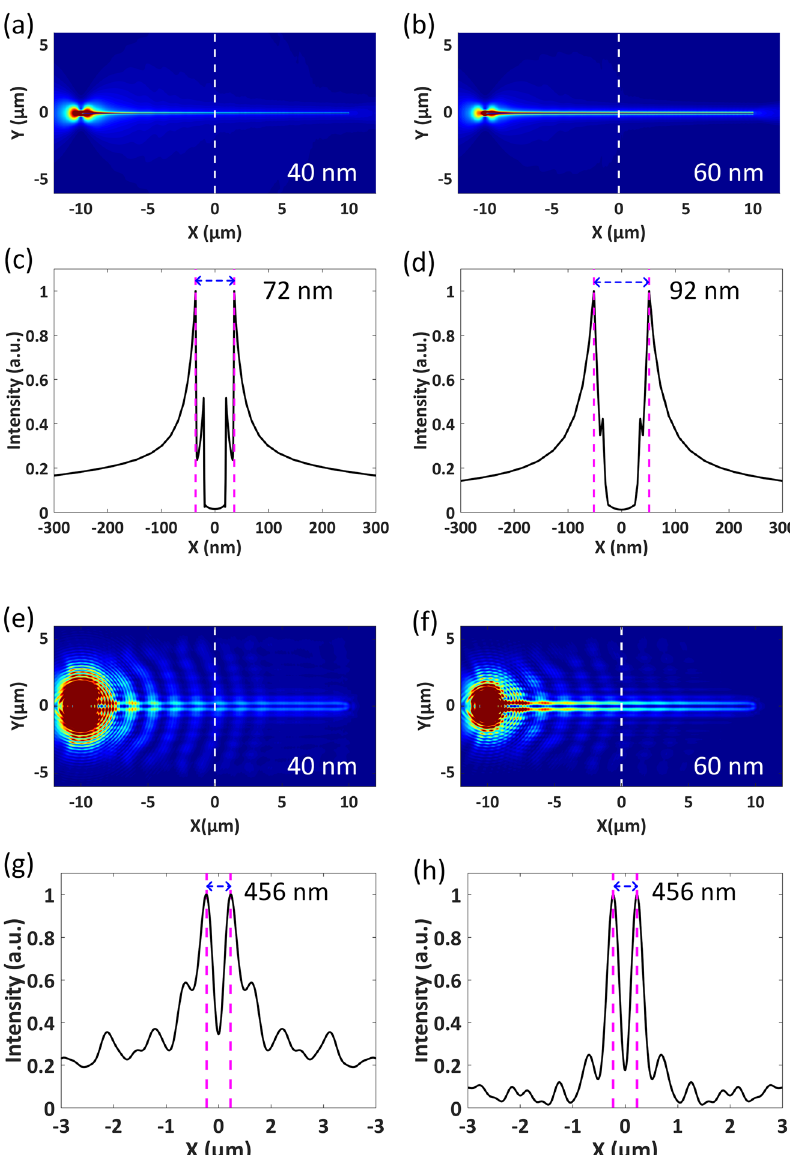
Figure 4: Simulated imaging of SPs propagating along an Ag NW. ThediameterofanAgNWis40nmin(a,c,e, g), and is 60 nm in (b, d, f, h). (a, b) The electric fi eld intensity ( | E | 2 ) distributions at the x - y plane in the near- fi eld. (c, d) The corresponding intensity pro fi les along the white dashed line in (a, b). The distance between two peaks is 72 nm in (c), and is 92 nm in (d). (e, f) The corresponding electric fi eld intensity distributions at the image plane in (a, b). (g, h) The corresponding intensity pro fi les along the dashed white line in (e, f). The distance